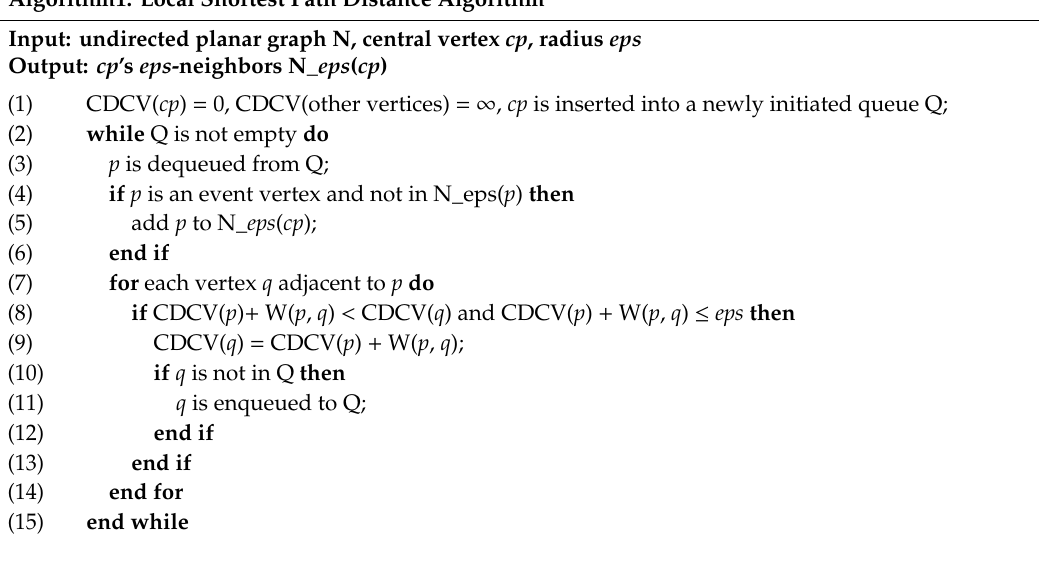
Table 1. Pseudocode of local shortest-path distance (LSPD) Algorithm. Algorithm1: Local Shortest Path Distance